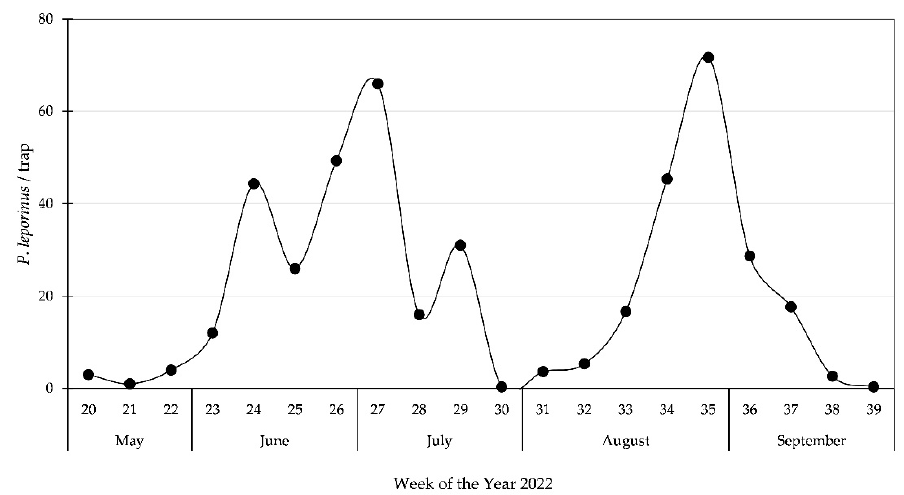
Figure 3. Abundance of adult Pentastiridius leporinus in Bickenbach, Hesse, 2022. The numbers represent means of three sticky traps per week.